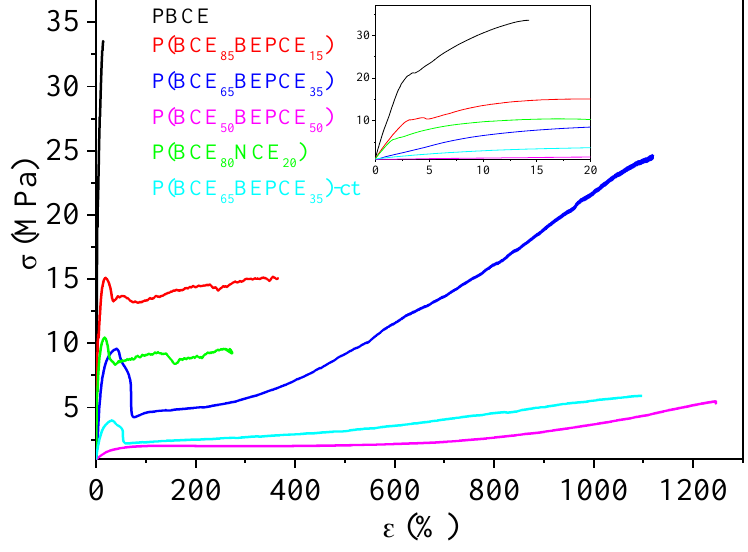
Figure 7. Stress-strain curves of PBCE, P(BCE m BEPCE n ), and P(BCE 80 NCE 20 ) random copolymers; In the inset: magnification of the low σ vs. ε region.